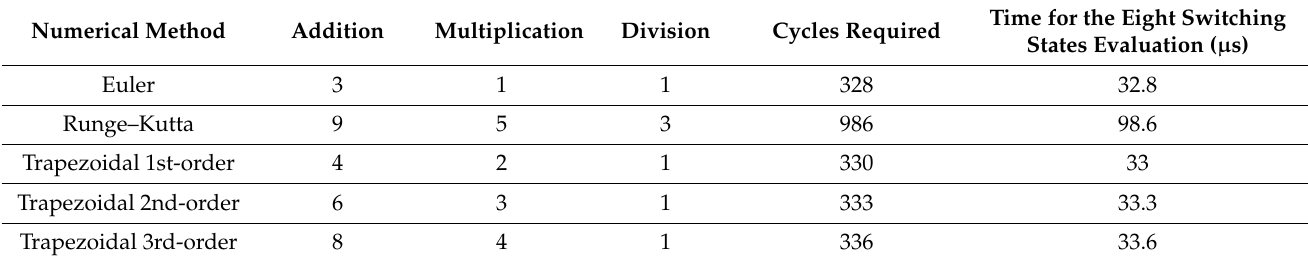
Table 4. Number of mathematical operations and cycles required.